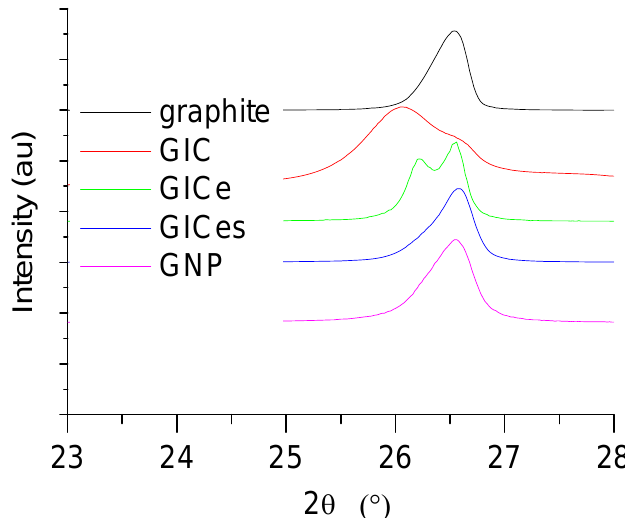
Figure 3. X-ray Diffraction (XRD) traces of graphite